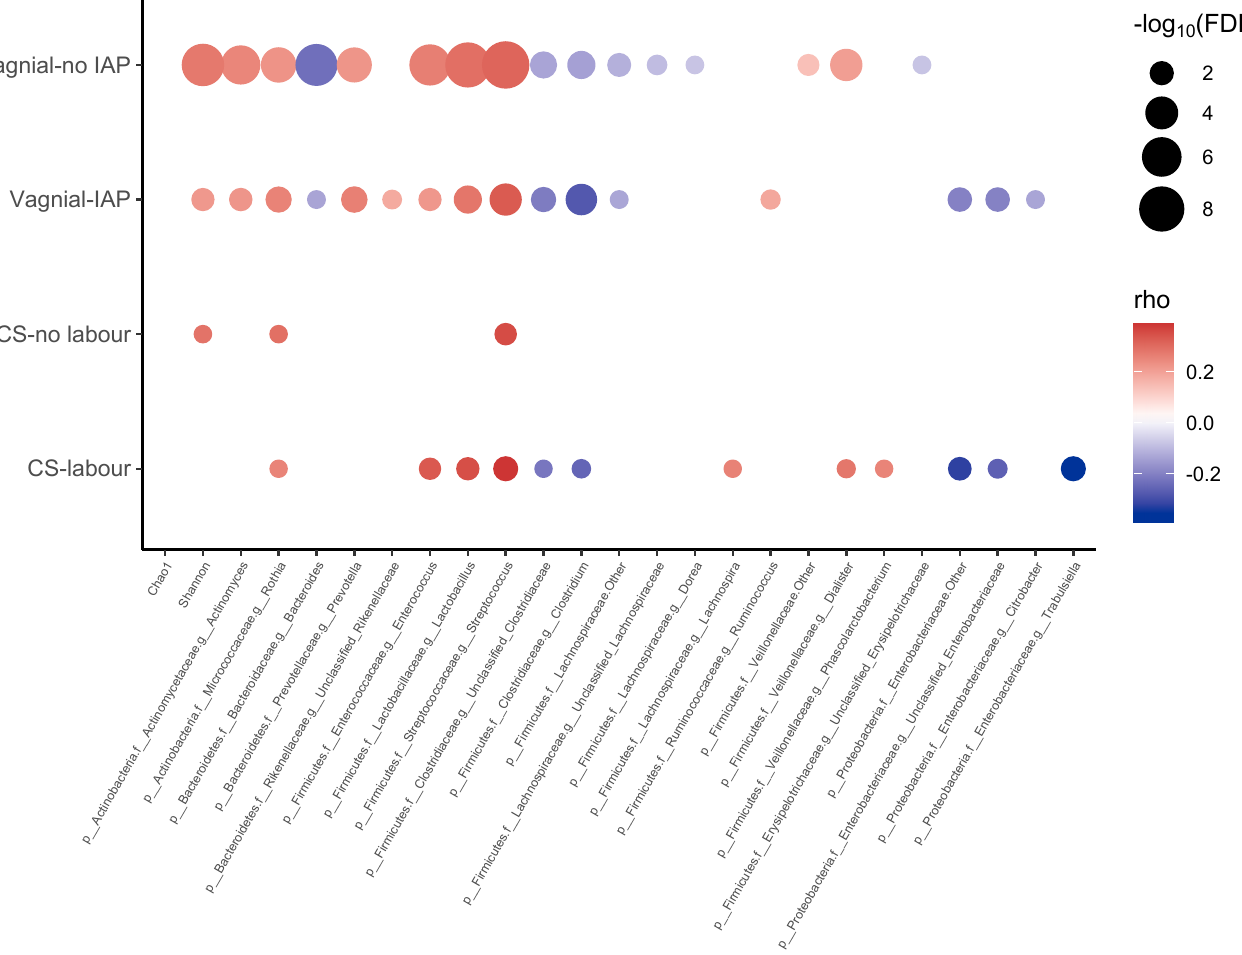
Figure 4. Correlation networks showing associations between Bifidobacterium and other gut microbial genera according to the birth mode in exclusively breastfed infants. Circle sizes and colour intensity (Red = positive, blue = negative) are proportional to the significance and strength of association, respectively. Only significant (FDR < 0.1) correlations were